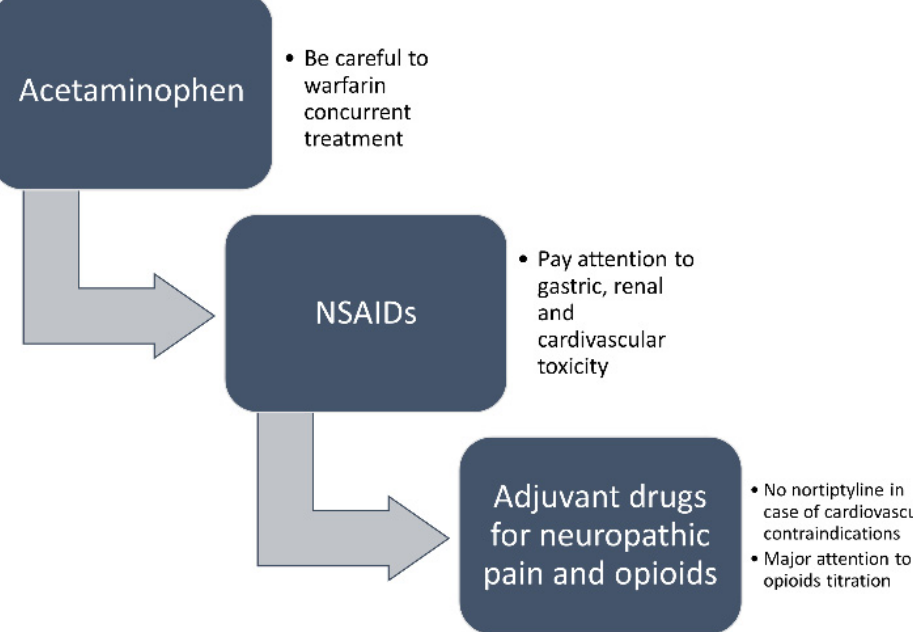
Figure 1. Schedule of analgesic treatment after observational pain